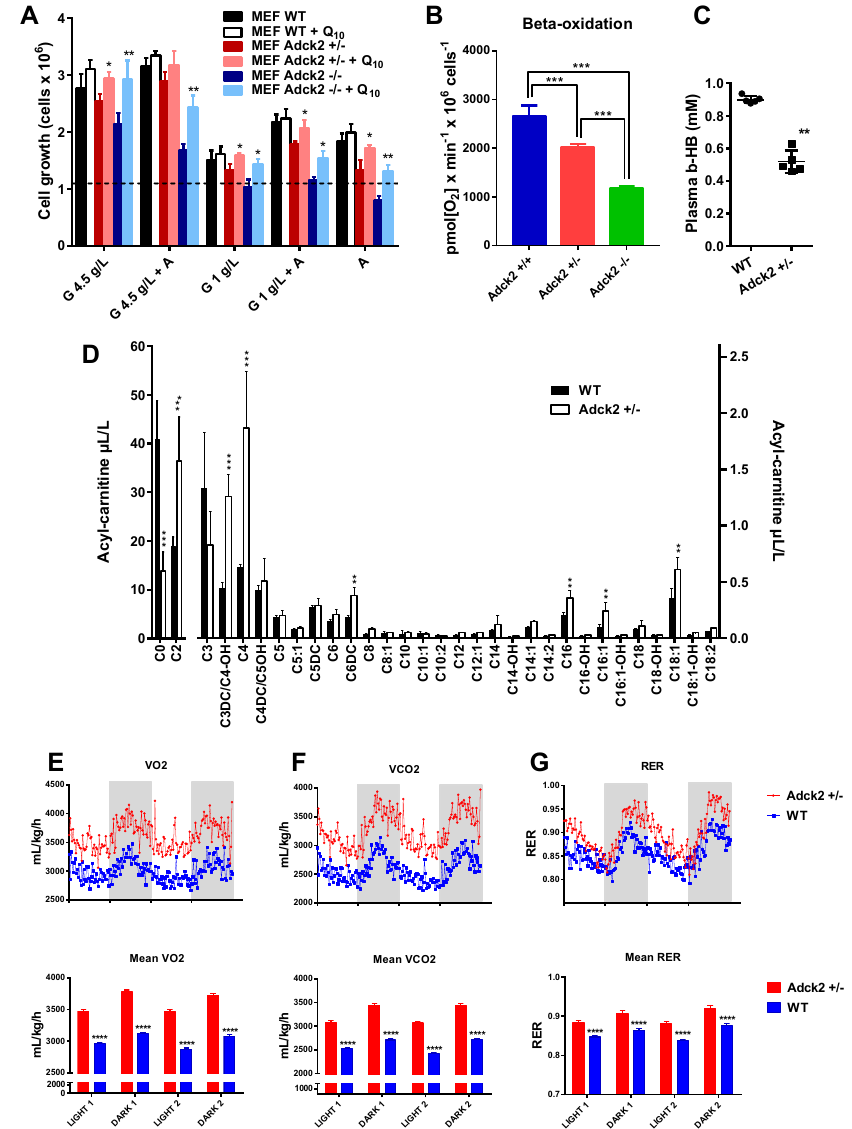
Figure 4. Metabolic changes associated with Adck2 insufficiency. ( A ) Effects of glucose and FA as carbon source on cell proliferation. MEFs were grown for 72 h in media containing either high glucose (4.5g/L), low glucose (1g/L), or 1 mg/mL fatty acids (‘A’, AlbuMax©) supplemented or not with 30 nM CoQ 10 . * p ≤ 0.05, ** p ≤ 0.01 vs. non-supplemented; ( n = 5). ( B ) Oxygen consumption rate of MEFs using palmitate as substrate. ( C ) Circulating concentrations of β -hydroxybutyrate in Adck2 +/ − and WT mice. ** p ≤ 0.01 vs. WT. ( D ) Acyl-carnitine profile measured in plasma of WT and Adck2 +/ − mice. ** p ≤ 0.01, *** p ≤ 0.005 vs. WT. Metabolic cages analysis of O 2 consumption ( E ), CO 2 production ( F ), and respiratory exchange ratio (RER) ( G) during two fed–fasted periods comparing Adck2+/ − and WT mice ( n = 6). **** p < 0.001 vs. WT. Data were analyzed using Student’s t test. Next, we used the indirect respiration calorimetry system (CLAMS metabolic chamber) to determine the preferred source of energy (fat vs. carbohydrates) for WT and Adck2 +/ − mice [48]. The respiratory exchange ratio (RER) is calculated using the ratio of CO 2 produced over O 2 consumed; RER of 1.0 indicates the predominant use of carbohydrates for energy production while RER of 0.7 is